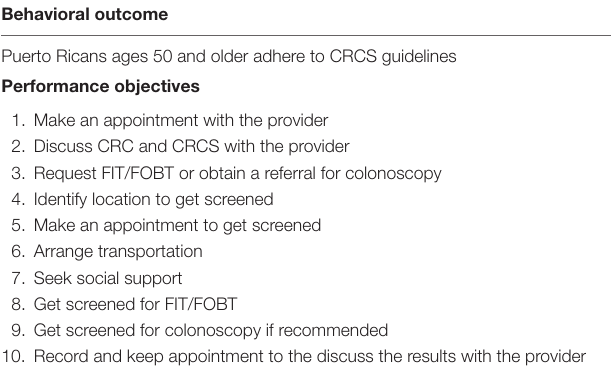
table 3 | Behavioral outcome with associated performance objectives. table 2 | Personal determinants and environmental factors influencing